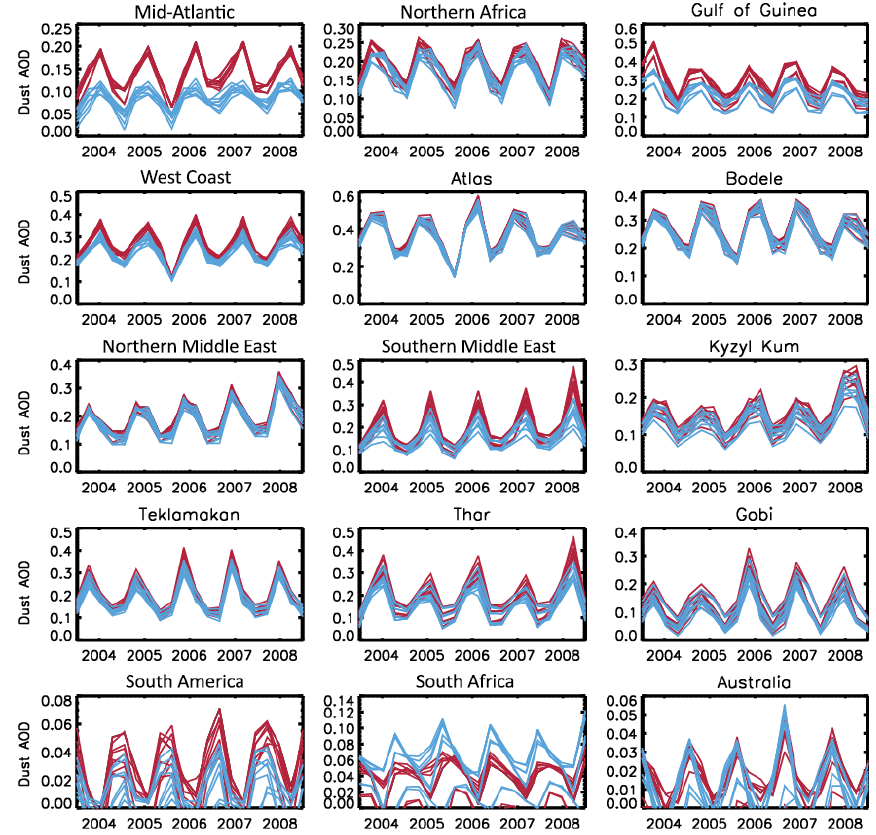
Figure 6. Observational dust AOD from MODIS Aqua and Terra with (red) and without (blue) filtering of 1 ◦ × 1 ◦ daily regions with over 80% cloud cover. Each line corresponds to a different combination of satellite and model when calculating the dust AOD, indicating the uncertainty. Results are shown without any bias correction from